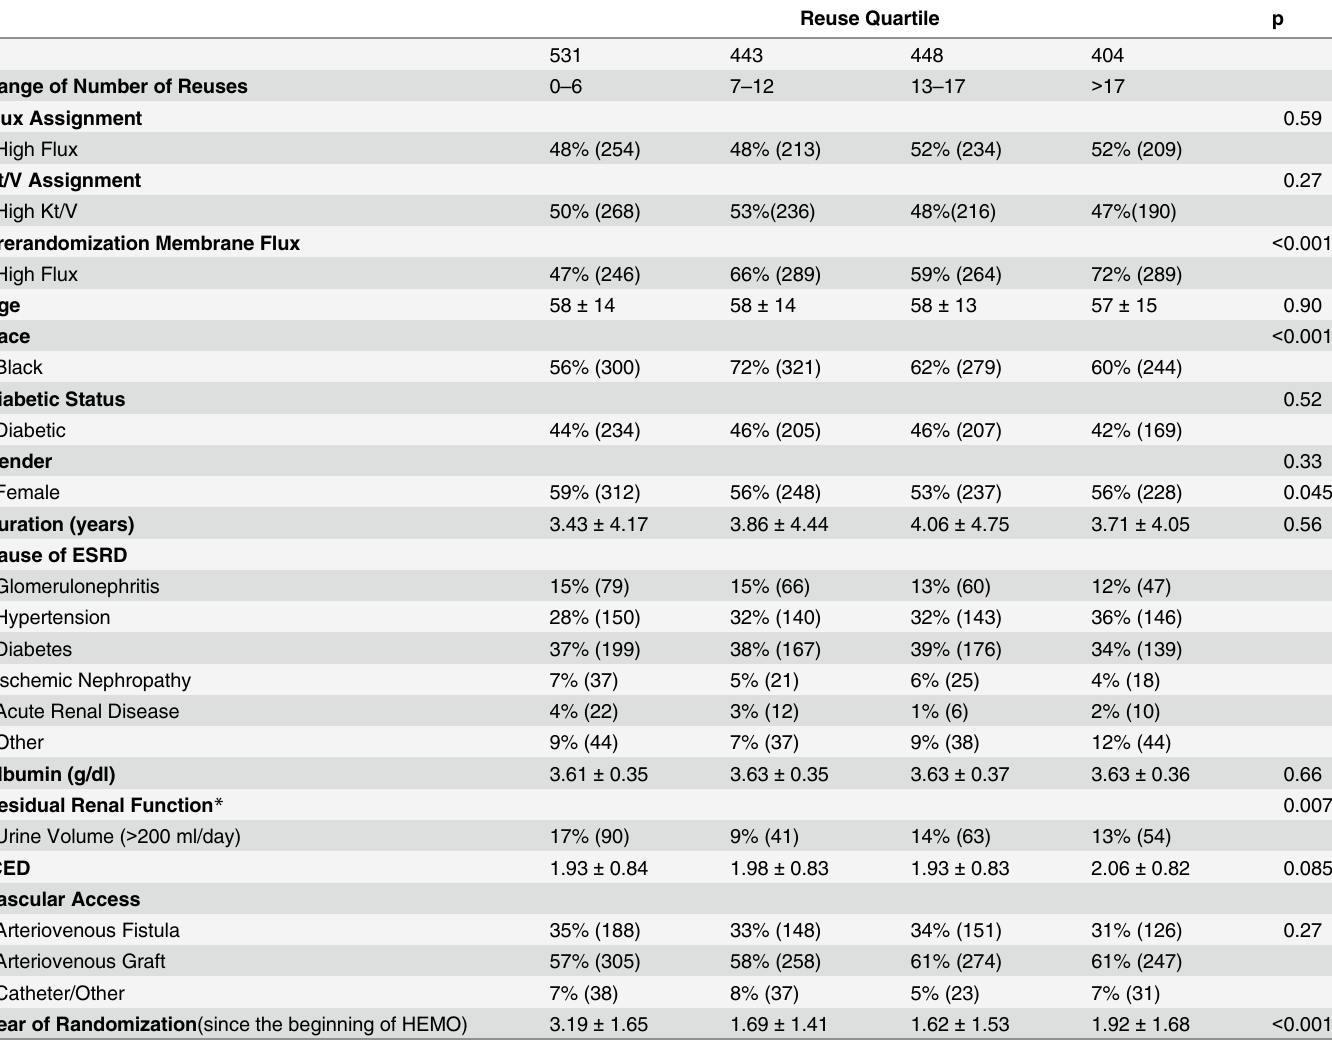
Table 1. Baseline Characteristics of HEMO Participants by Reuse